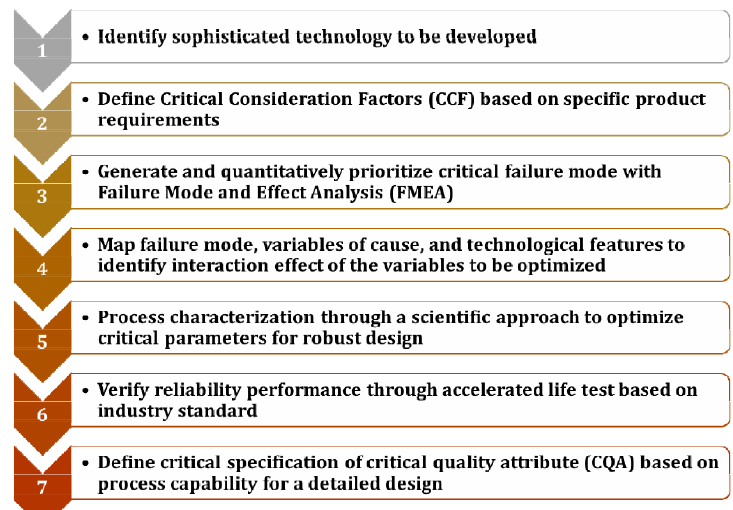
Figure 8. Overview of the development tools methodology